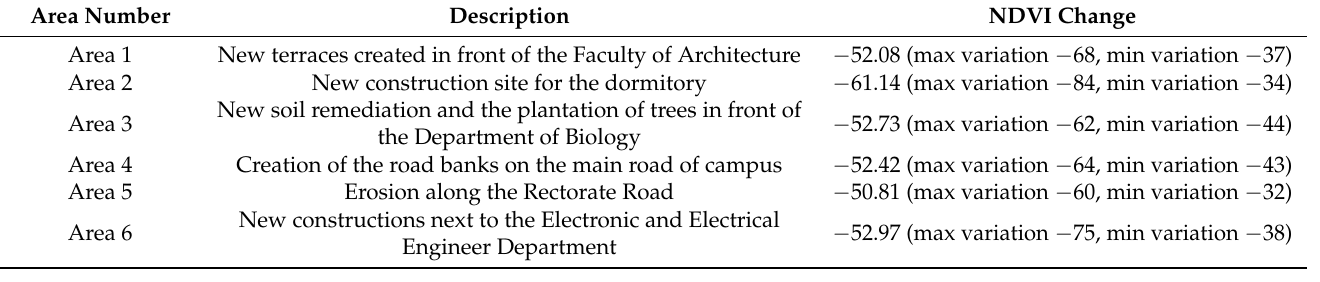
Table 2. Synthesis of the Areas description.